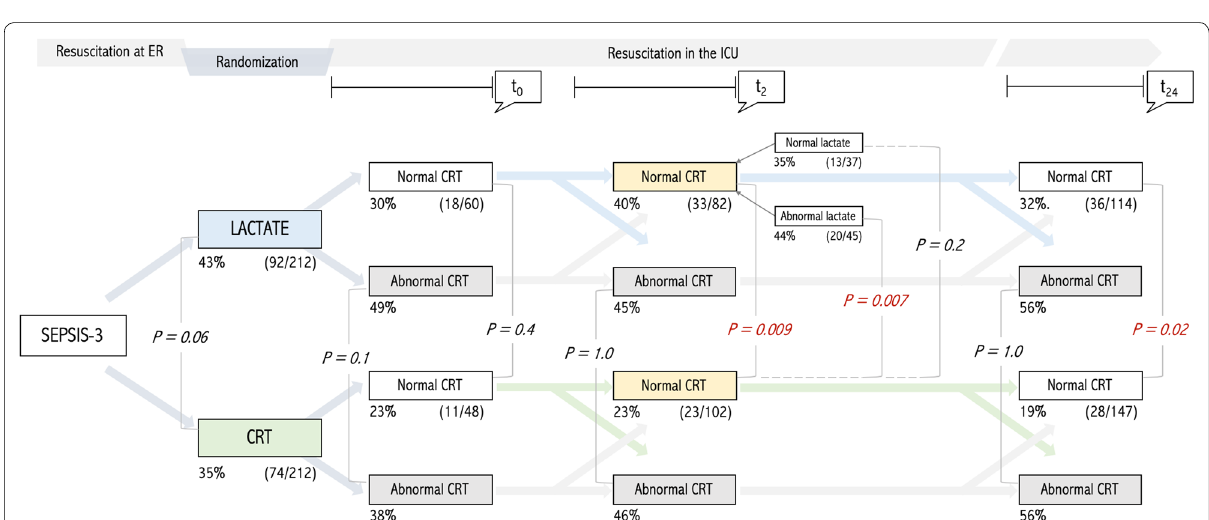
Fig. 3 Patients distribution at 0, 2, 8 and 24 h and associated outcome according to randomization group, under CRT perspective. Percentages refer to 28‑day mortality. All patients started with hyperlactatemia. Lactate arm pursued lactate normalization or significant lowering, irrespective of CRT state. CRT arm pursued CRT